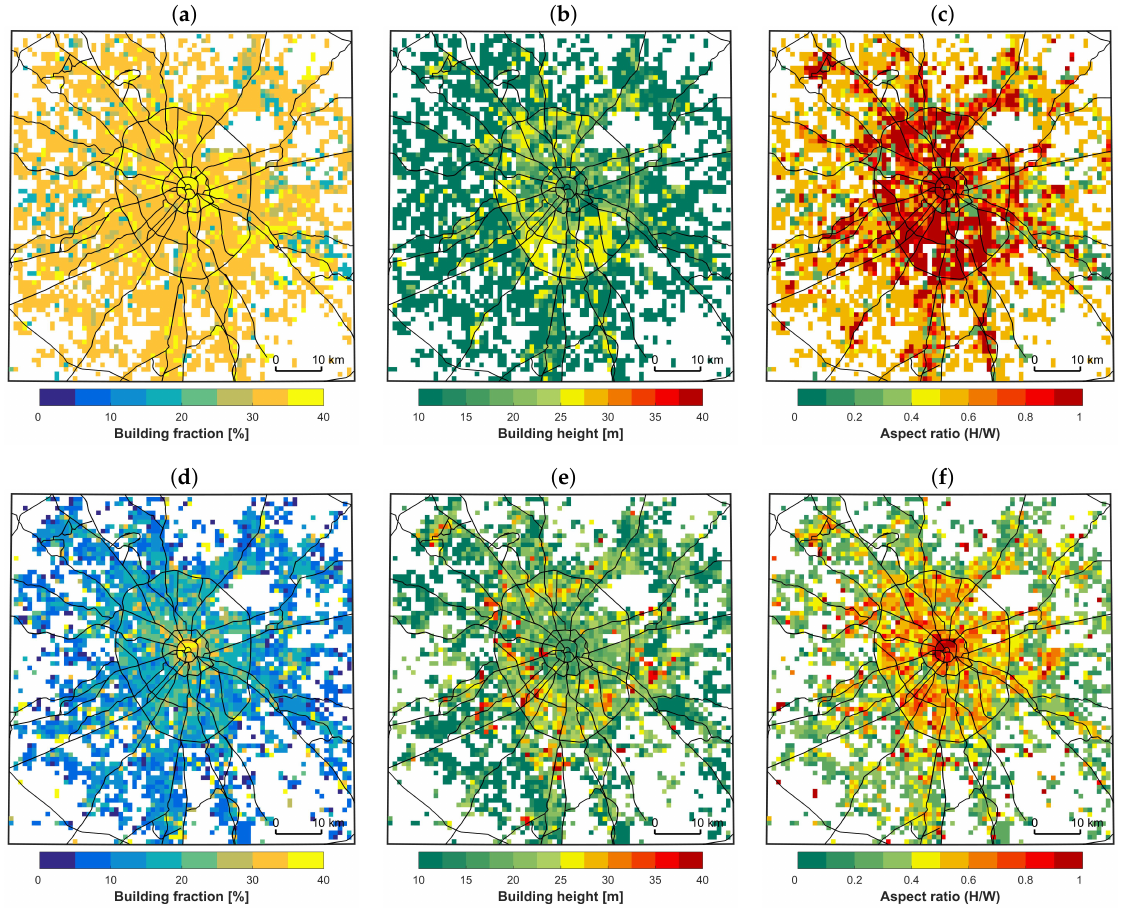
Figure 6. Comparison of building area fraction of the urban fraction. R ( a , d ), building height, H ( b , e ) and H / W ratio ( c , f ) derived from LCZ-based ( a – c ) and reference ( d – f ) UCP datasets. Temperature anomaly maps allow to get a broader perspective on the simulated and observed